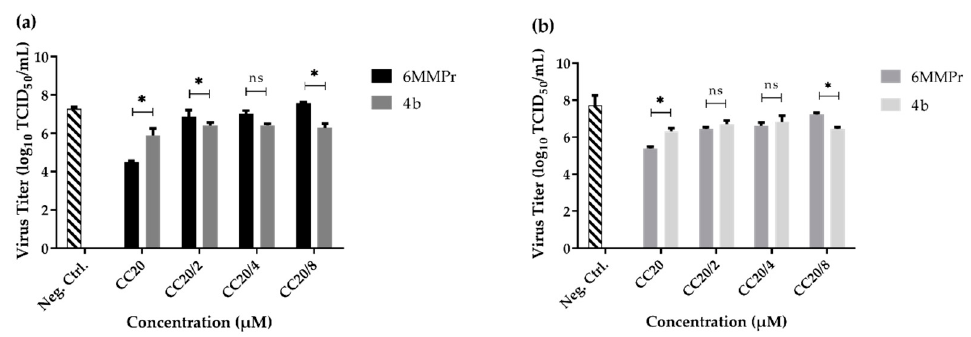
Figure 6. Comparison of anti-ZIKV activity between 6MMPr and 4b after three- and five-days post-infection (d.p.i.). 6MMPr and compound 4b were submitted to a post-infection test when Vero cells was infected with ZIKV at MOI 0.1 for 2 h then treated with compounds. Concentrations used in the test corresponded to CC 20 ( 4b = 136.90 µM; 6MMPr = 60.50 µM), CC 20 /2 ( 4b = 68.45 µM; 6MMPr = 30.25 µM), CC 20 /4 ( 4b = 34.22 µM; 6MMPr = 15.13 µM) and CC 20 /8 ( 4b = 17.11 µM; 6MMPr = 7.56 µM). The experiment was done in triplicates and values are the mean and the SD. Statistical analysis was made between compounds using t-test on GraphPad Prism program. * = significative; ns = not statistically significant for p < 0.05. ( a ) 3 d.p.i. from both compounds. ( b ) 5 d.p.i. from both compounds.